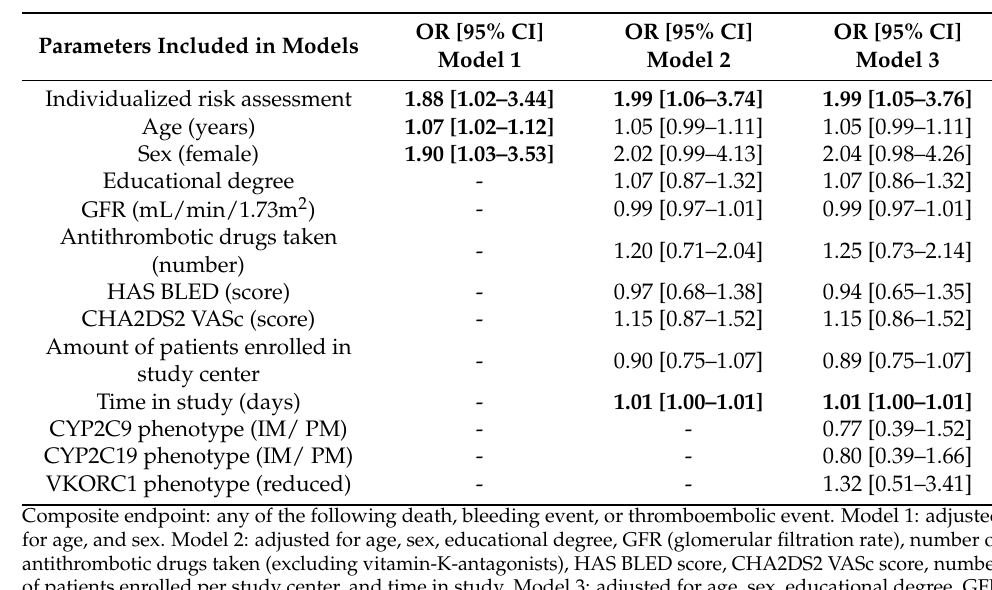
Table 4. Secondary analyses for the composite endpoint comparing the individualized with the standardized risk assessment group including only patients with the intake of vitamin-K-antagonists ( n = 209).